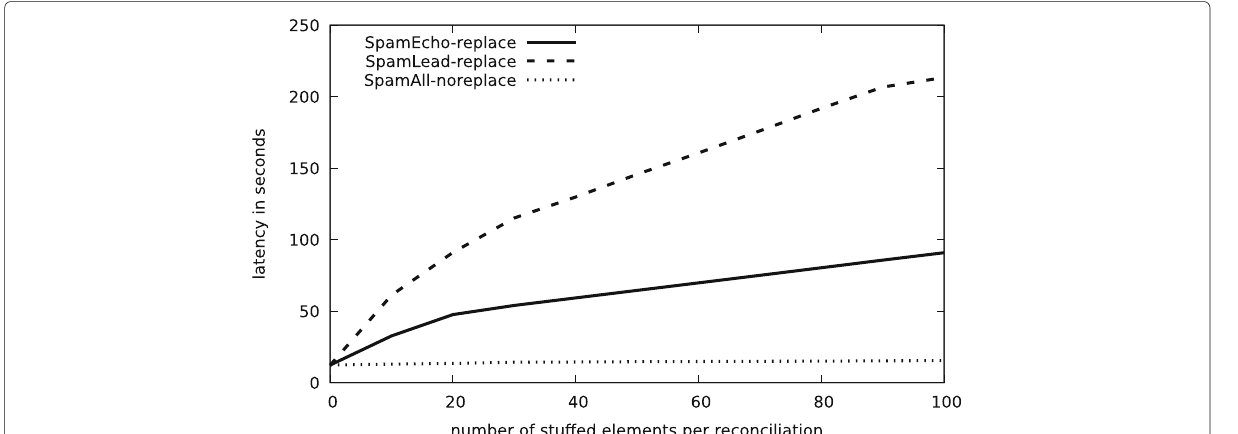
Fig. 8 Runtime of BSC for 100 elements of 64 bytes and only correct peers. Average over 50 executions